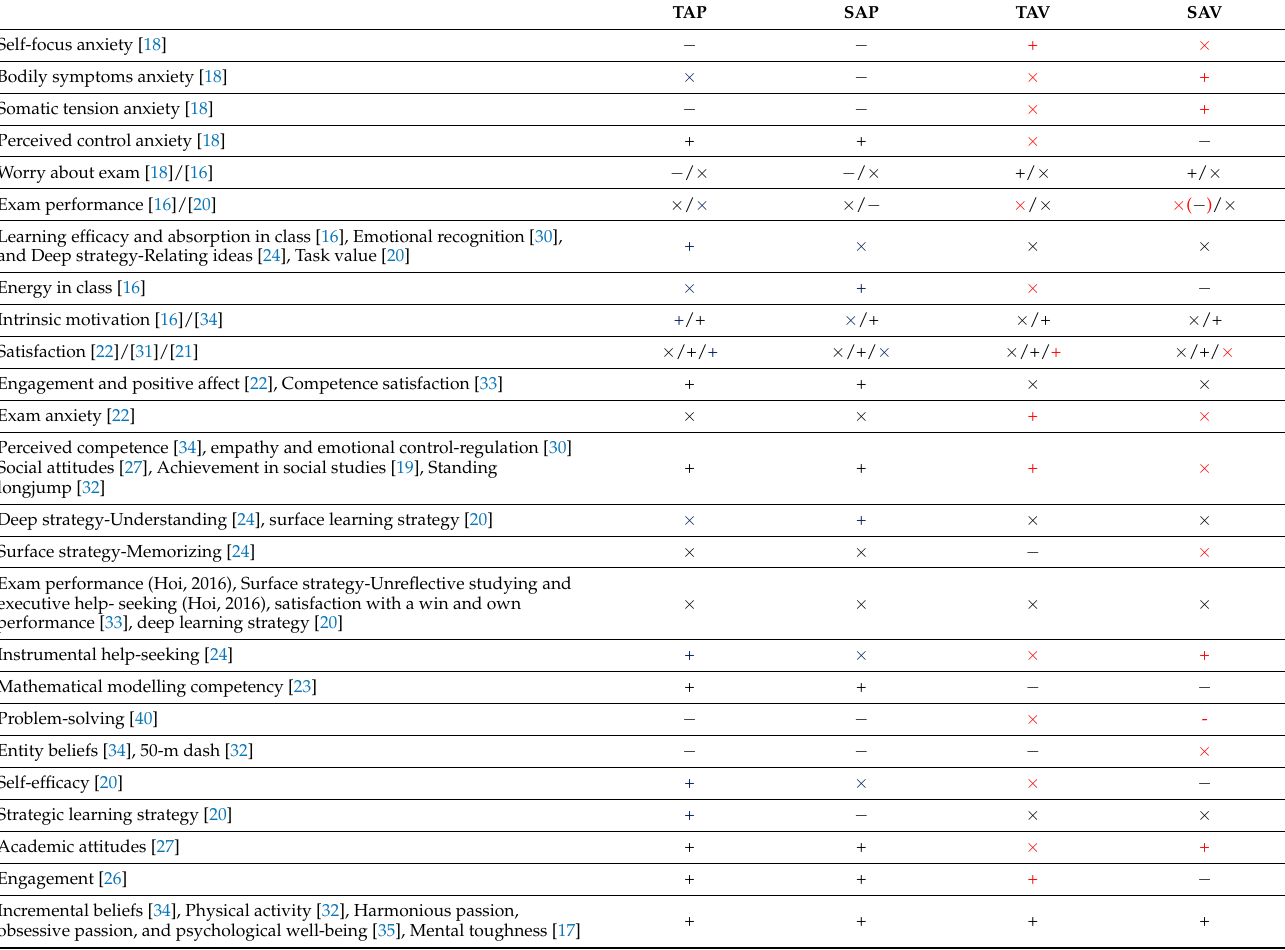
Table 1. Empirical status of the correlations between achievement goals and outcome variables. TAP SAP TAV SAV